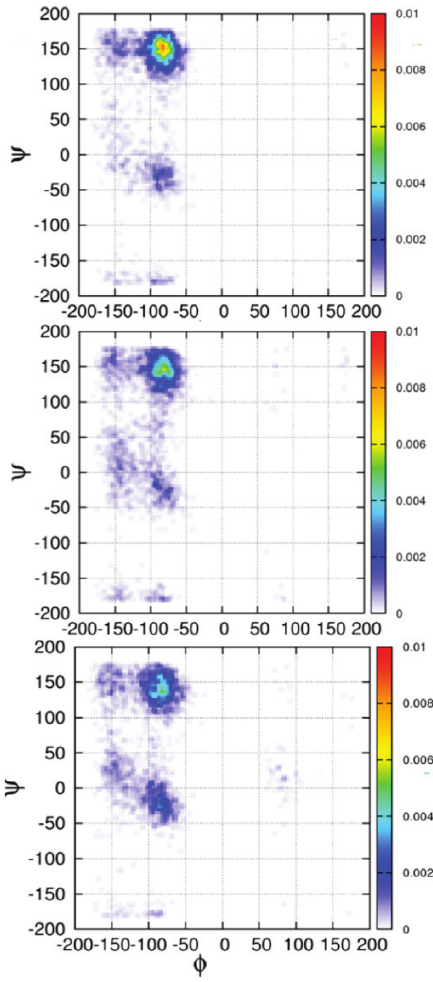
Figure 11. Ramachandran plots for cationic AAA (upper panel) and zwitterionic AAA (middle panel) and AdP (lower panel) obtained by MD simulations using the OPLS force field and SPC/E water model. (Taken from ref. [15] with